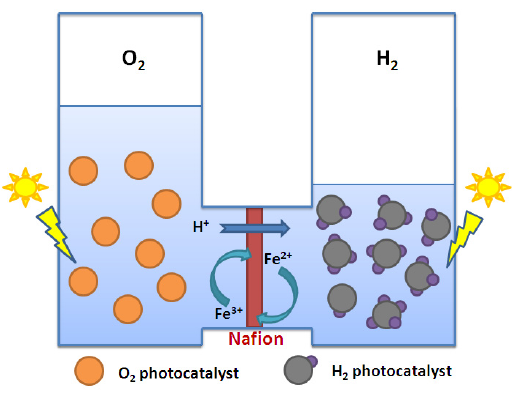
Figure 10. Concept of a novel twin-reactor